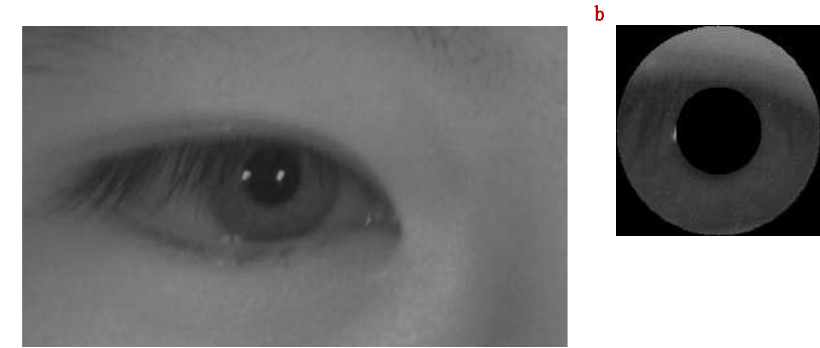
Figure 7. Eye area enhanced with CPSSA-CLAHE. ( a ) Eye region after image enhancement.